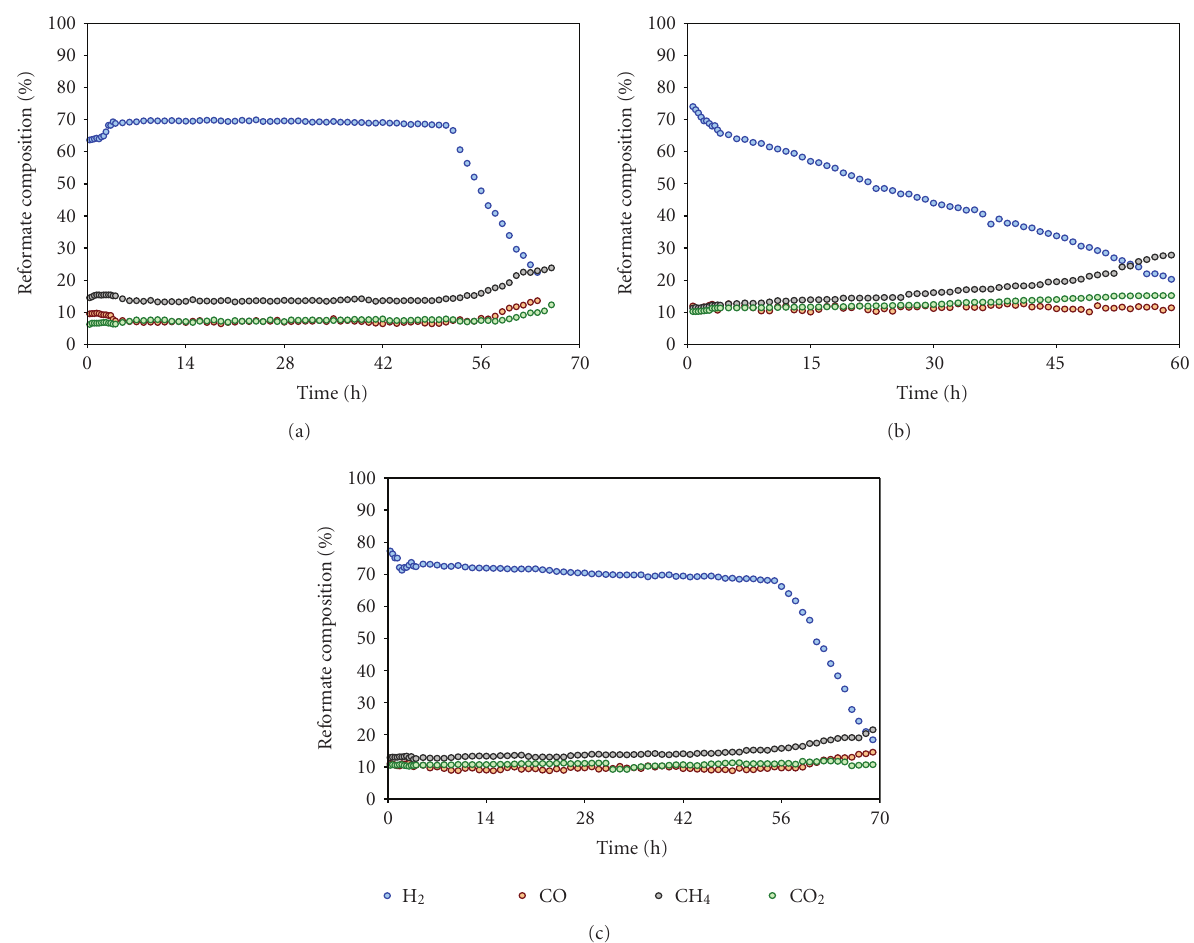
Figure 6: Composition of kerosene reformates using: (a) Ru, (b) Pd, and (c) Rh.